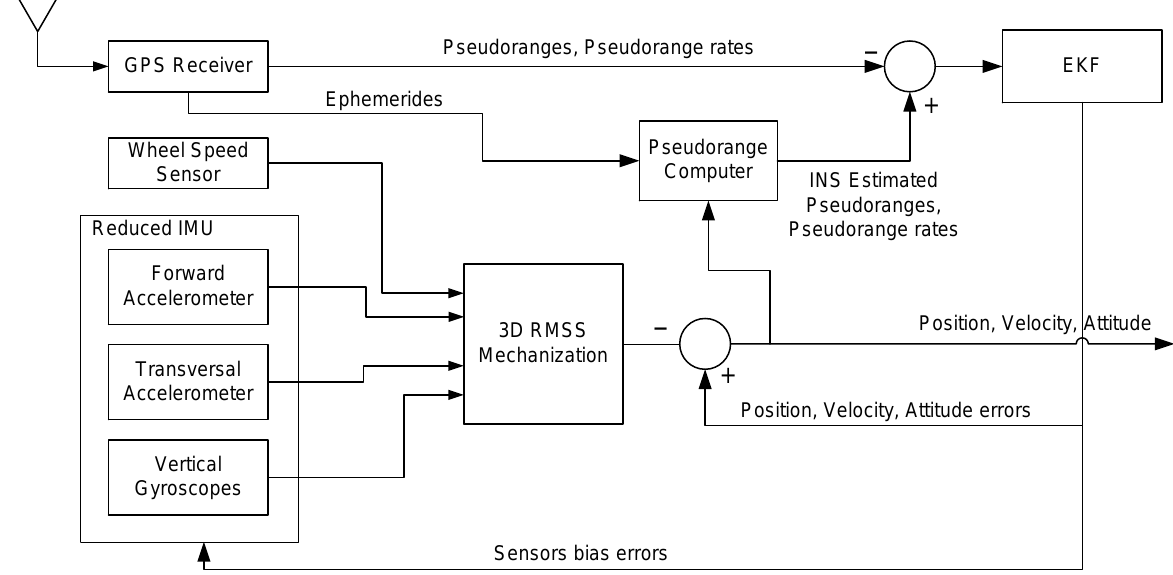
Figure 4. EKF-based RISS/GPS tightly-coupled integrated navigation